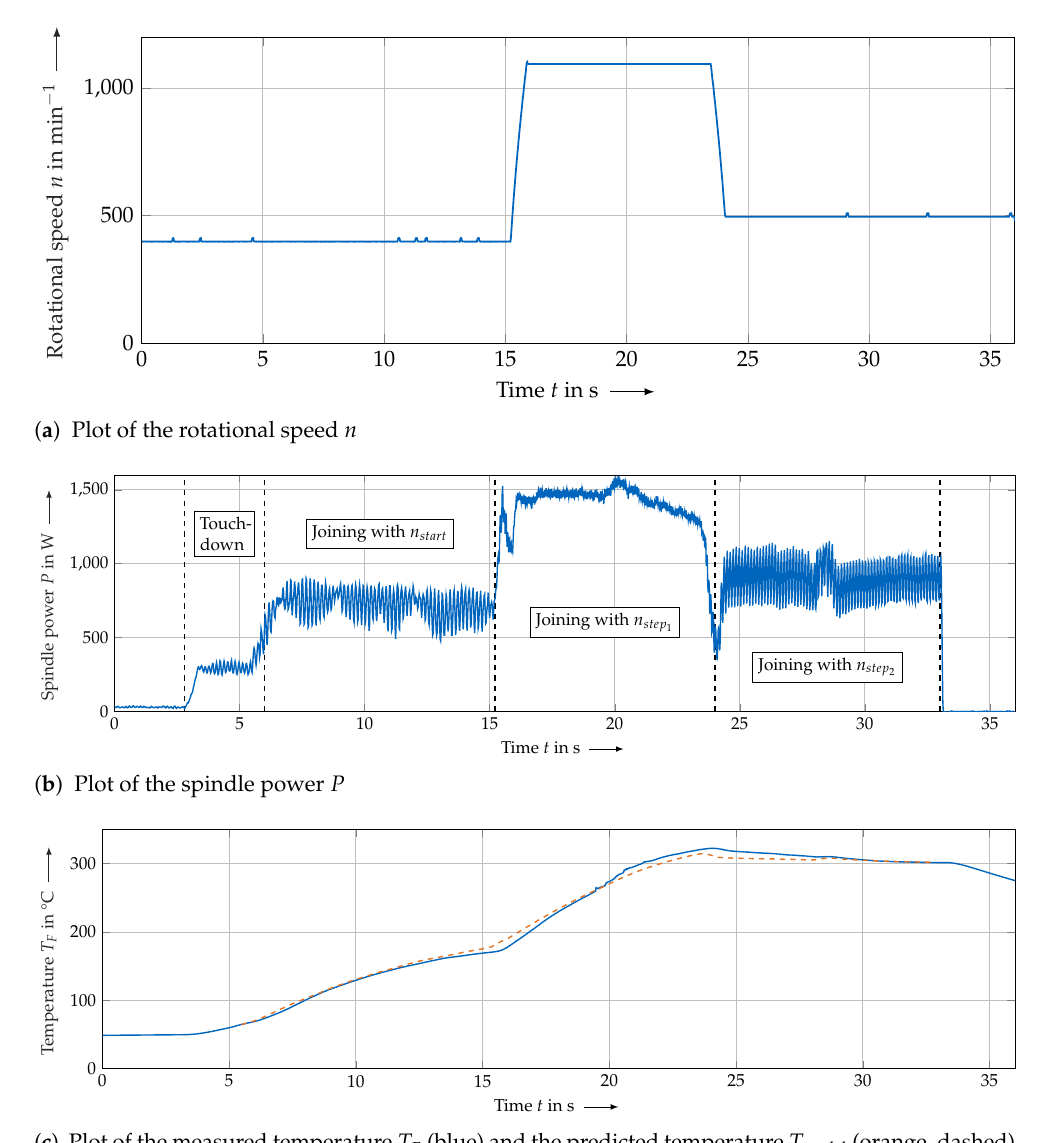
( c ) Plot of the measured temperature T F (blue) and the predicted temperature T model (orange, dashed) Figure 5. Plot of the measured parameters n , P , and T F for experiment PS 5, and the predicted temperature T model from the system model. Table 2. Parameters for the optimized system